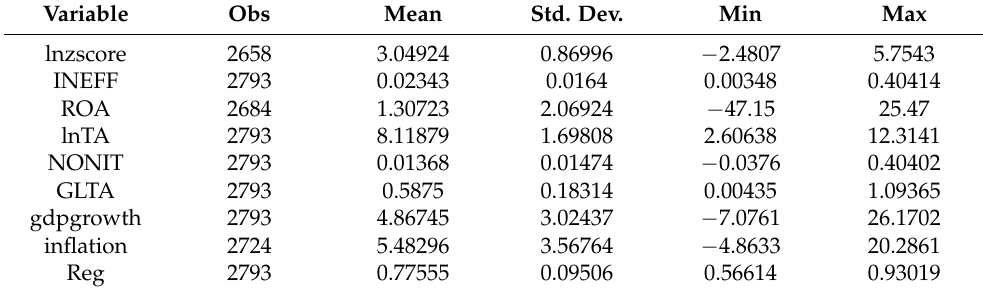
Table 2. Descriptive Statistics (Conventional).